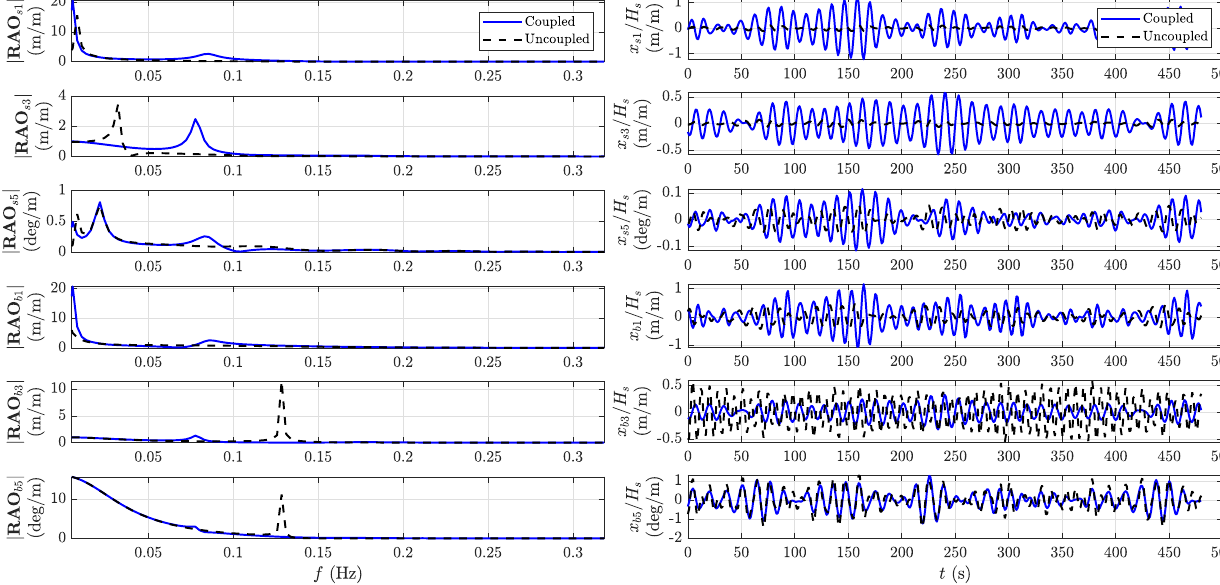
Figure 9. As in Figure 8 but with R BA = 13.71m (i.e., with m BA = m spar